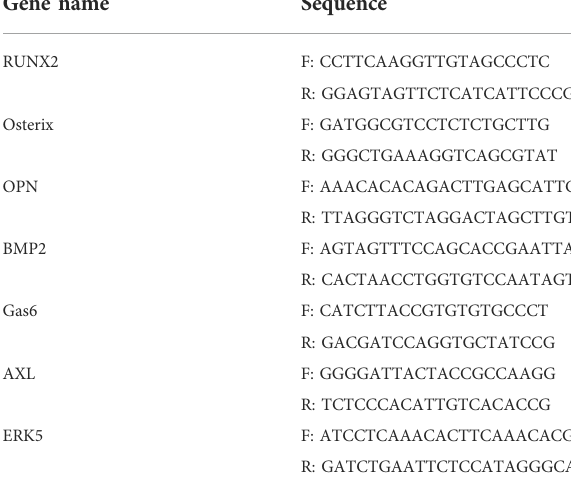
TABLE 1 Primers ’ sequence of